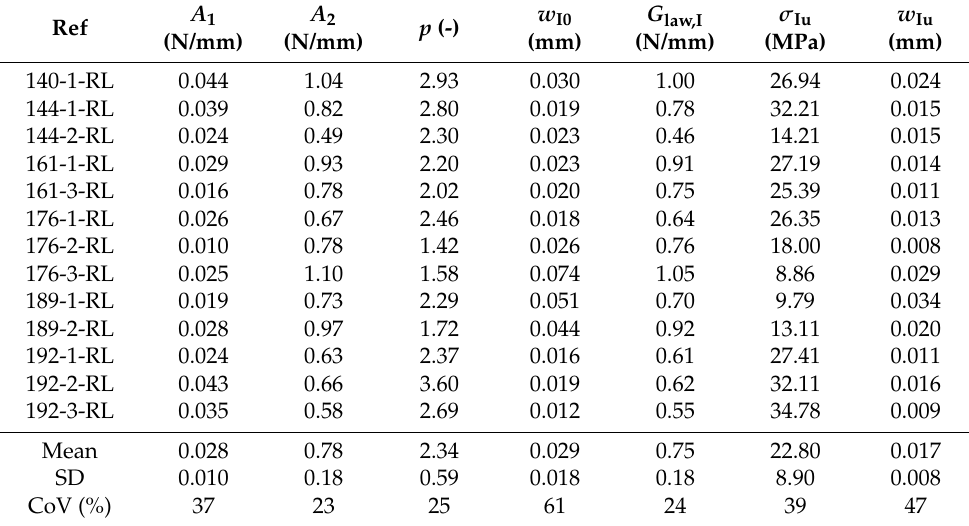
Figure 10. Cohesive laws in RL ( left ) and TL ( right ). Mean cohesive law is highlighted in bold. Table 5. Logistic function parameters ( A 1 , A 2 , p , and w I0 ), maximum stress ( σ Iu ) and relative displacement ( w Iu ), as determined by CBBM equations, from specimens with the RL crack system.